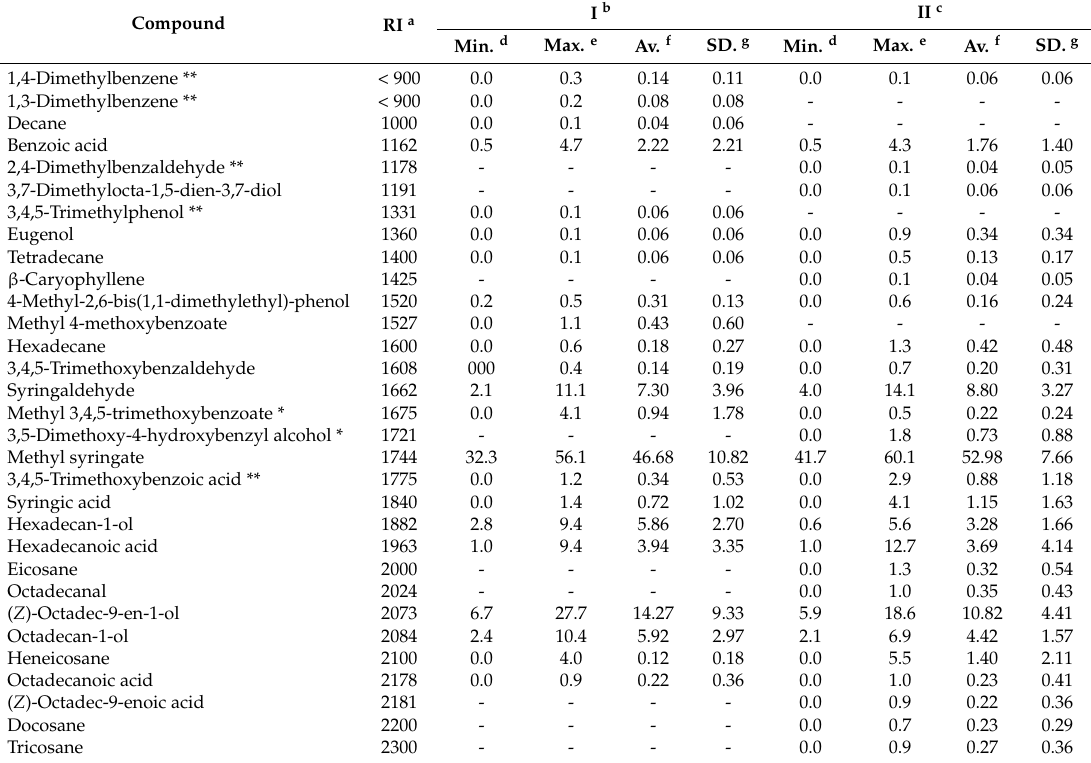
Table 2. The compounds identified by GC-FID/MS analysis of the honey